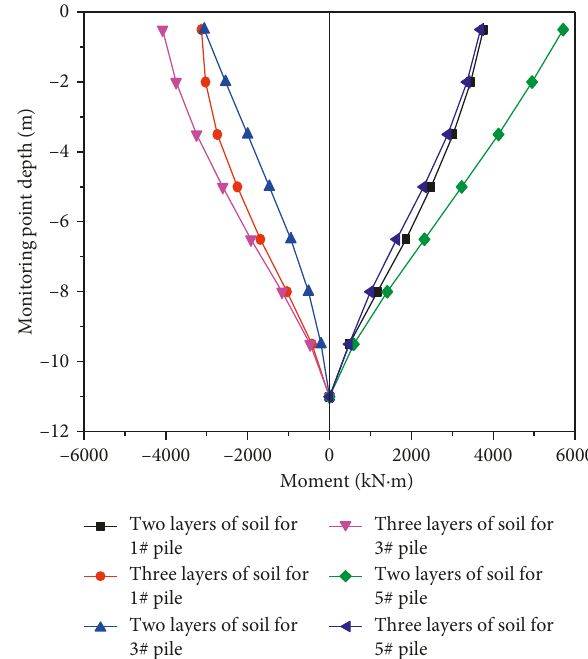
Figure 18: Comparison of the bending moments for different soil